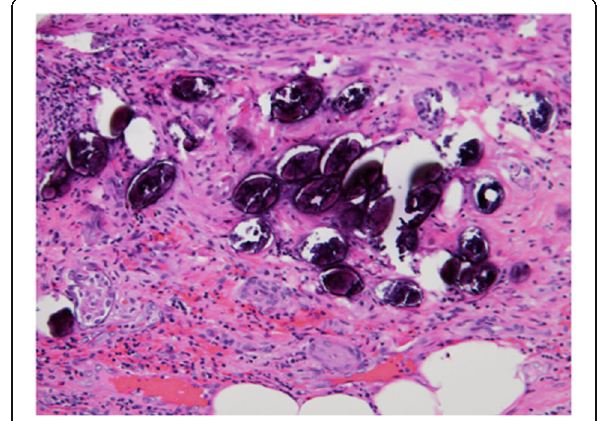
Fig. 4 Calcified schistosome eggs deposited in the submucosa. Severe infiltration of lymphocytes and fibrosis was recognized around the oval bodies. The numerous oval bodies were morphologically consistent with schistosomiasis. (magnification, × 400, H&E